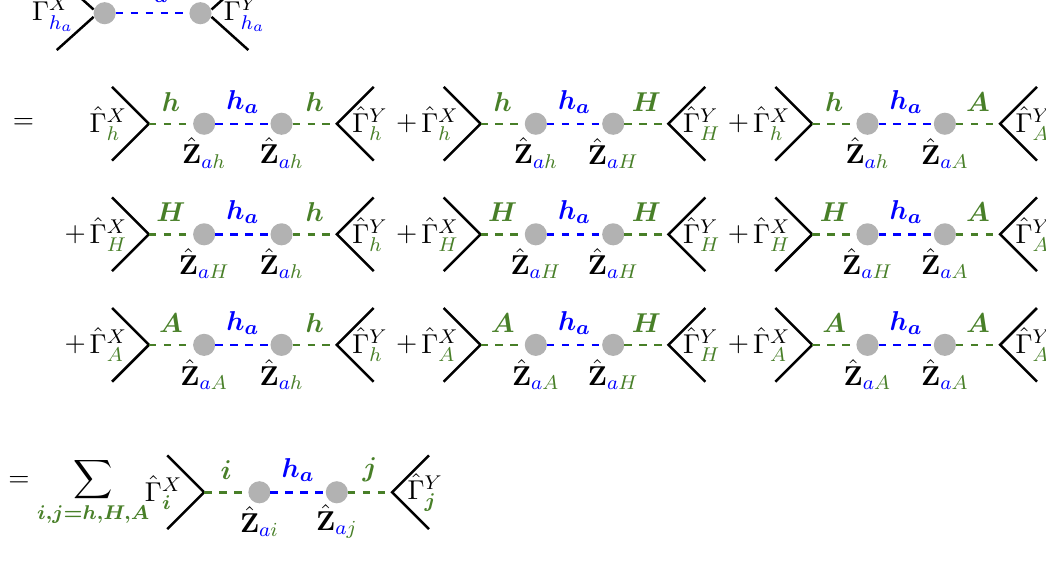
from eq. (4.30) of h a ( a = 1 ; 2 ; 3) a ( p 2 ), a